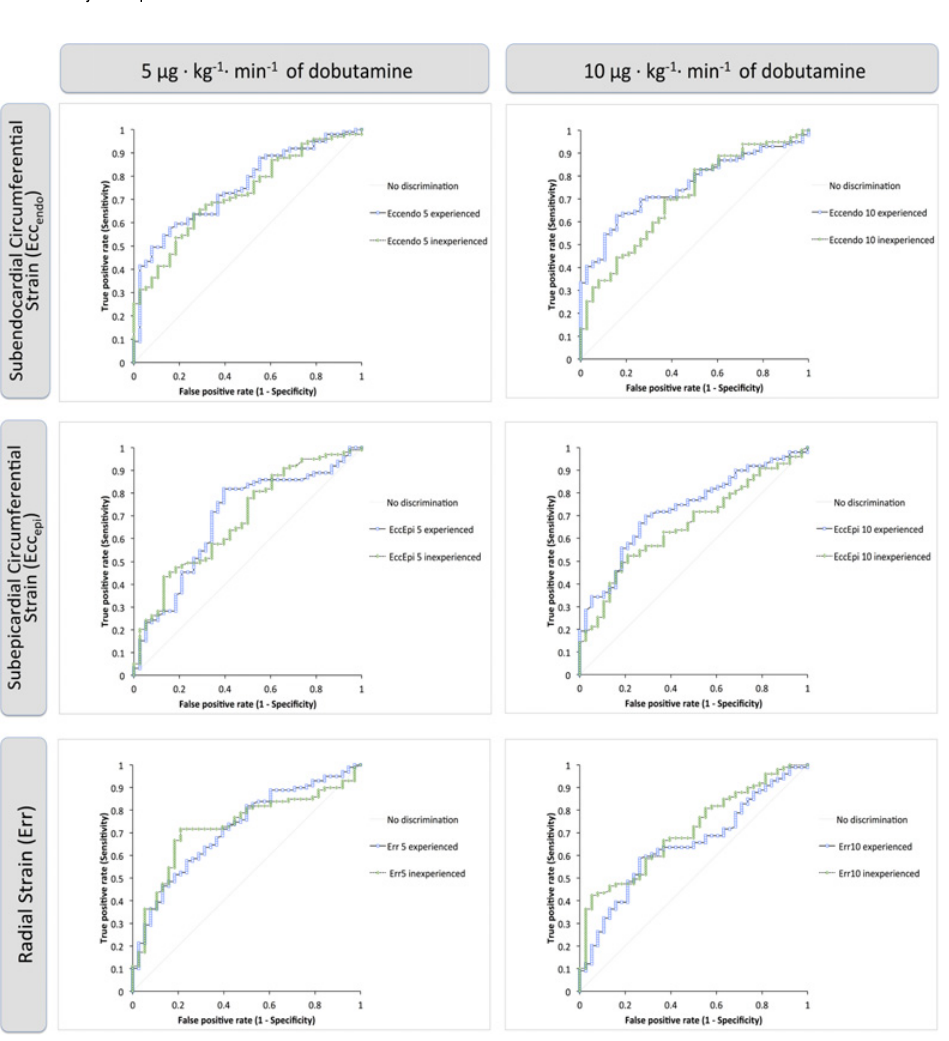
Fig 4. Receiver operator characteristics (ROC) for different strain values and observers. The figure shows the diagnostic accuracy of the different strain values derived from one experienced and one inexperienced observer to detect a visual improvement by (cid:3) 1 category as determined from the experienced observer ’ s visual